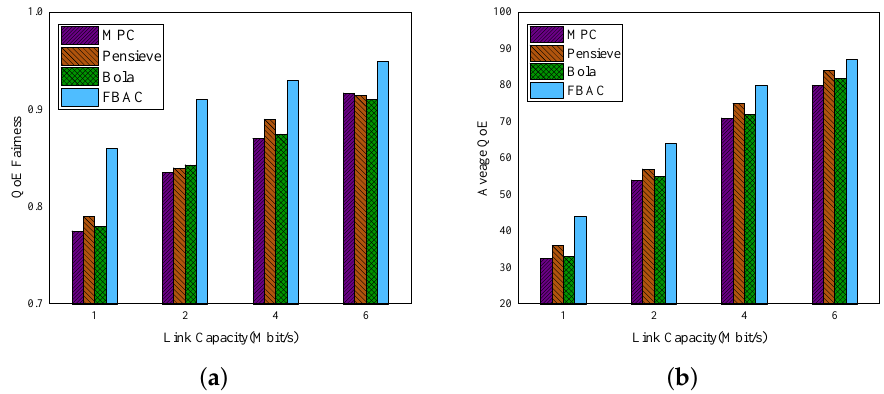
Figure 3. Experimental results of fixed bandwidth. ( a ) QoE fairness; ( b ) QoE